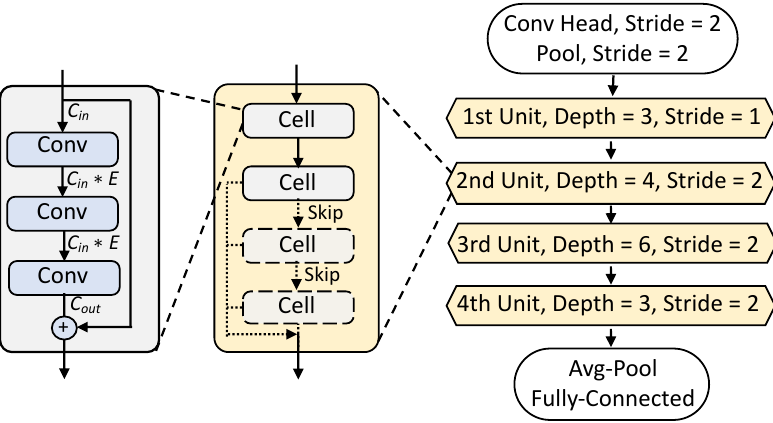
Figure 3. ResNet-50 with different depths, channel numbers and expansion